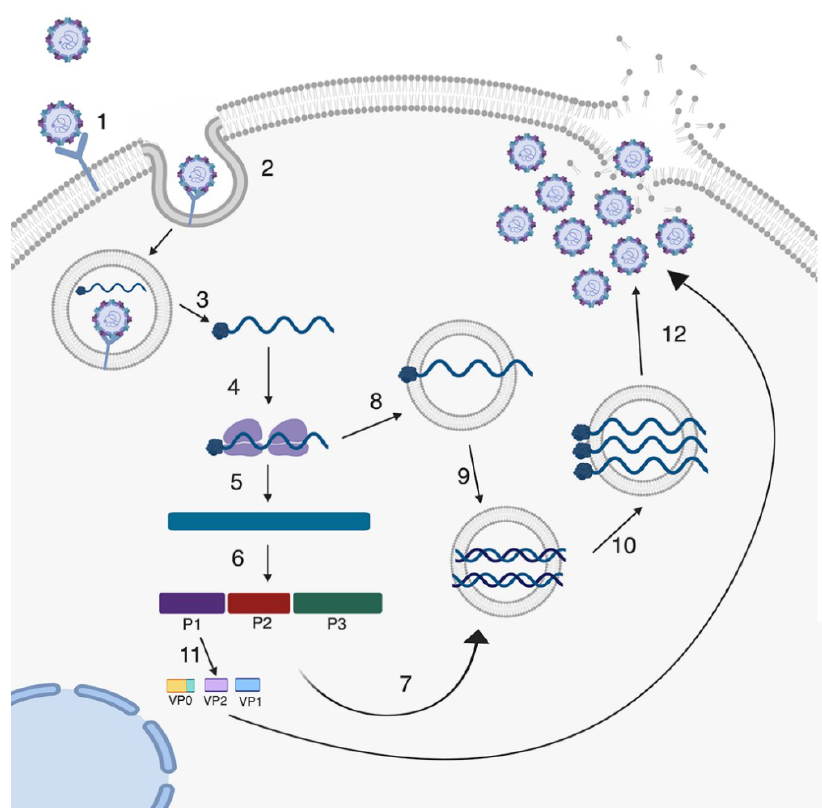
Figure 2. Enterovirus life cycle. Enteroviruses enter the cell through receptor-mediated endocytosis (1). Following endocytosis, uncoating of the virion occurs in the endosome and the positive-stranded RNA along with the covalently-linked VPg protein is released into the cytoplasm (2 and 3). Viral RNA is translated by host ribosomes making a single polyprotein that is catalytically cleaved by enterovirus proteases 2A pro and 3C pro (4, 5, and 6). After production and accumulation of non-structural proteins, including the viral polymerase, viral RNA is then replicated using the virally-encoded RNA-dependent RNA polymerase to generate a double-stranded RNA (8 and 9). The negative sense RNA serves as the template to make more positive sense RNA. This newly produced RNA can be the template to produce more positive sense RNAs or serve as the genome for progeny viruses (10). Capsid proteins assemble and newly synthesized positive-stranded viral RNA is packaged into virion (11). Finally, new progeny virions are released either by non-lytic release, where virions are released in vesicles (not shown), or are released when the cell undergoes lysis (lytic release)